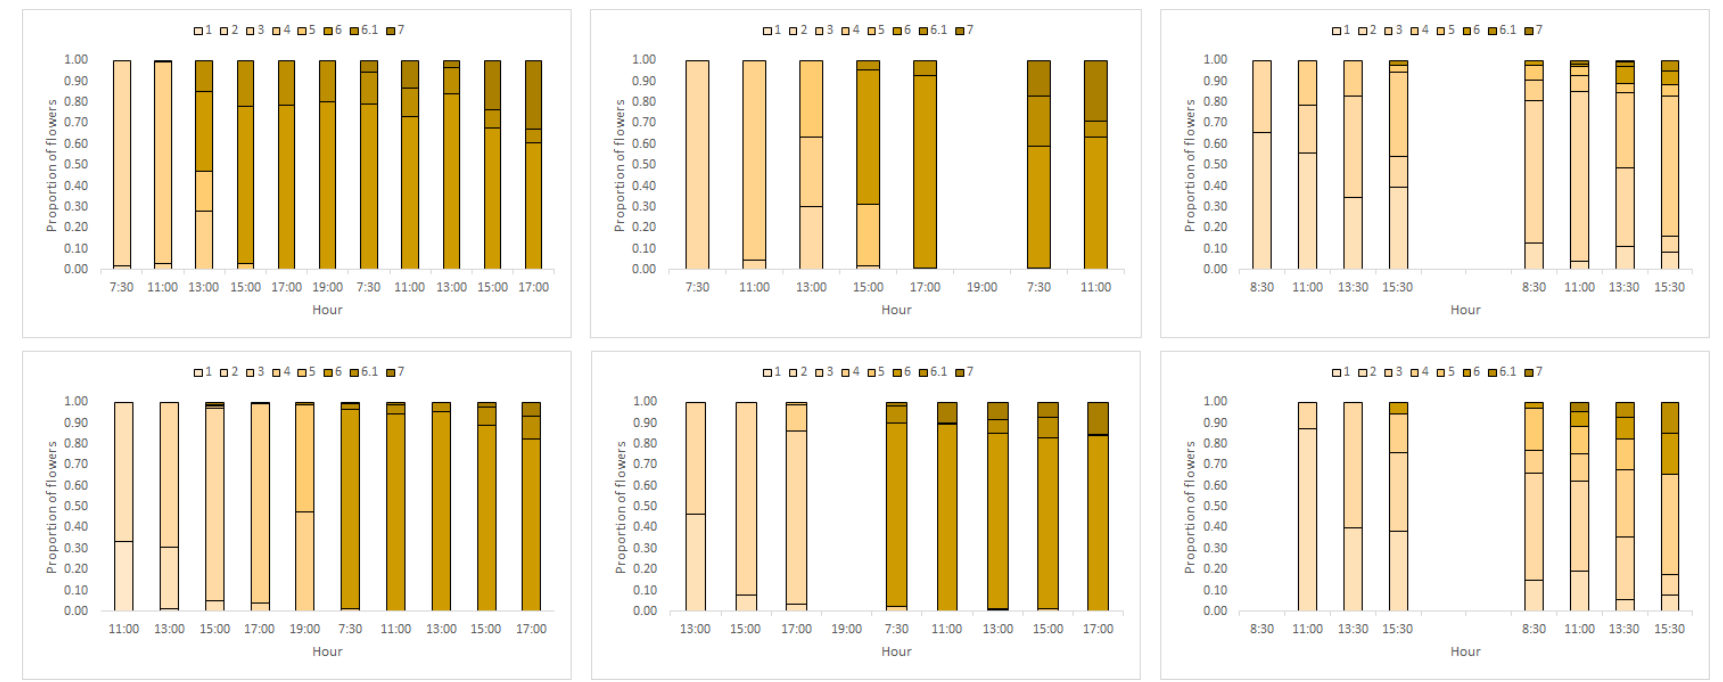
Figure 4. Detailed daily flower progression in ‘Early’ and ‘Late’ trees at early-, mid-, and end-season. Flower stages are described in Table 1. Darker shades correspond to more advanced flower stages.